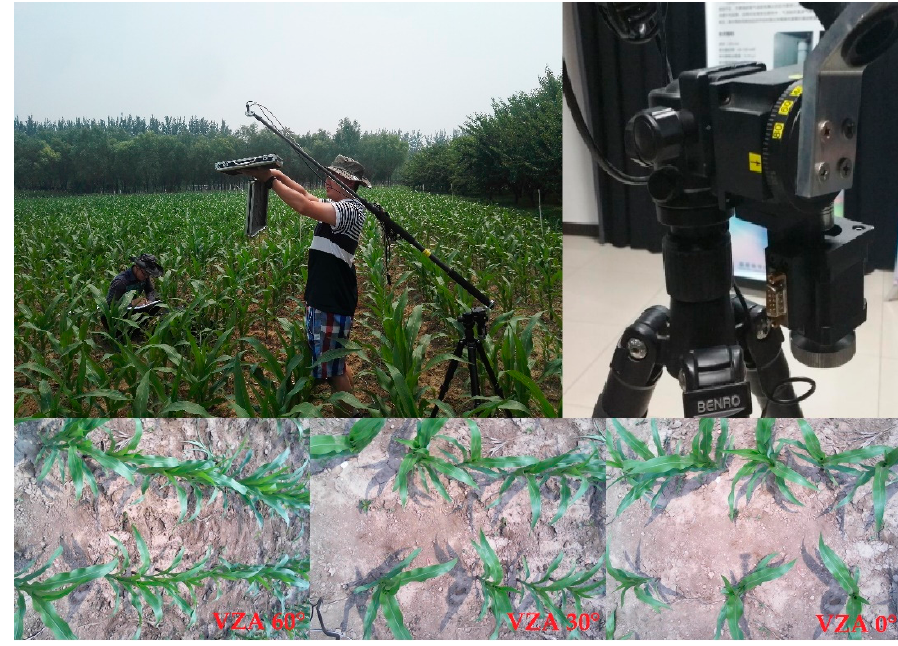
Figure 1. Multi-angular spectral reflectance acquisition in sixth-leaf stage.